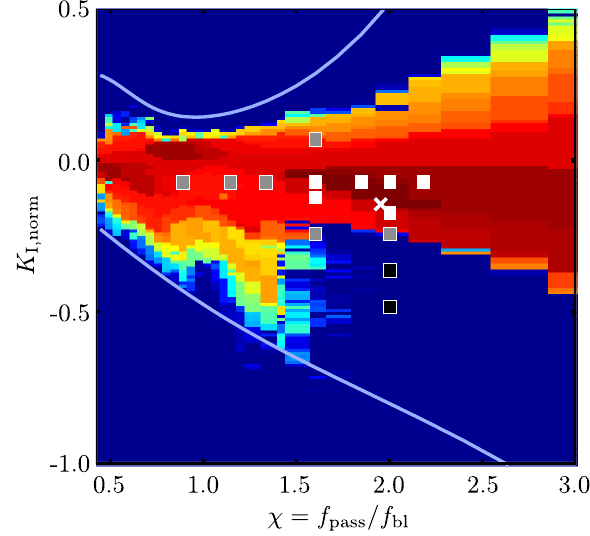
FIG. 9. Settling time of the feedback for nonlinear tracking simulations compared to beam experiment run C ( (cid:4) ) and other stable ( h ), marginally stable ( ), and unstable ( j ) operating